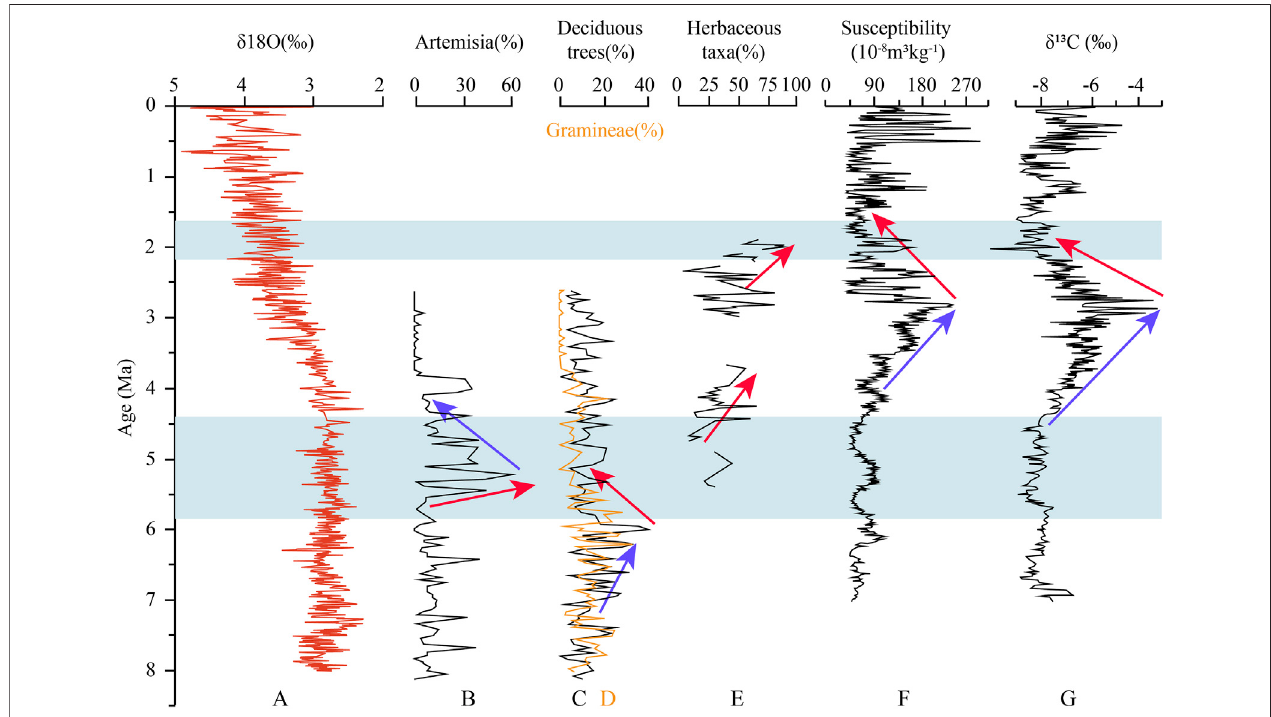
FIGURE7| RegionalclimaticinformationaroundtheShanxiRiftSystem(locationofChaona,Yushe,andLingtaiin Figure1 ). (A) Oxygenisotoperecordsofbenthic foraminifera from boreholes 1,147 and 11,488 in the South China Sea (Cheng et al., 2004). (B) Pollen content of Artemisia of the Chaona section (Ma et al., 2005). The higher values indicate more arid condition. The red arrow and blue arrow signify drought trend and wet trend, respectively, hereinafter the same. (C) and (D) Pollen contentofdeciduoustreesandGramineaeoftheChaonasection(Maetal.,2005). (E) PollencontentofherbaceoustaxafromtheYusheBasin(Shietal.,1993). (F) magnetic susceptibility of eolian deposits from Lingtai (An et al., 2005). (G) Soil carbonate δ 13 C from Lingtai (An et al., 2005).